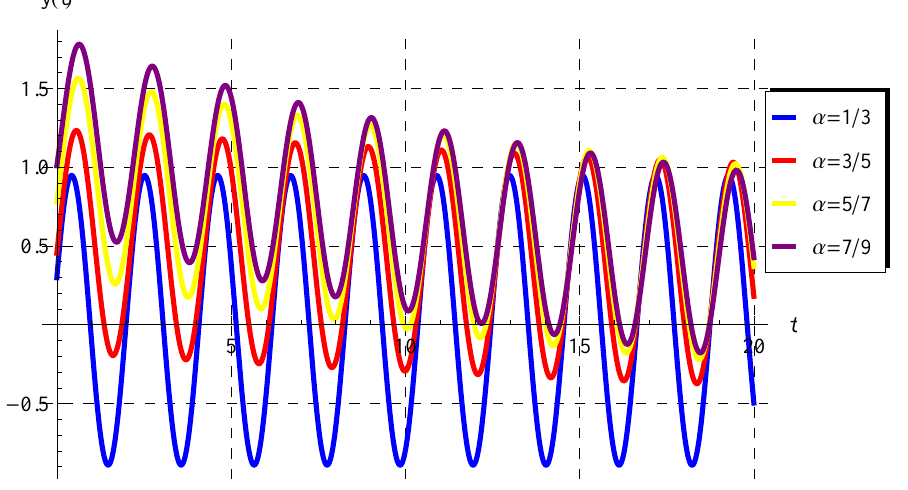
Figure 3. Graphs of the solution (47) at a = 1, b = 1, A = 2, ω = 1